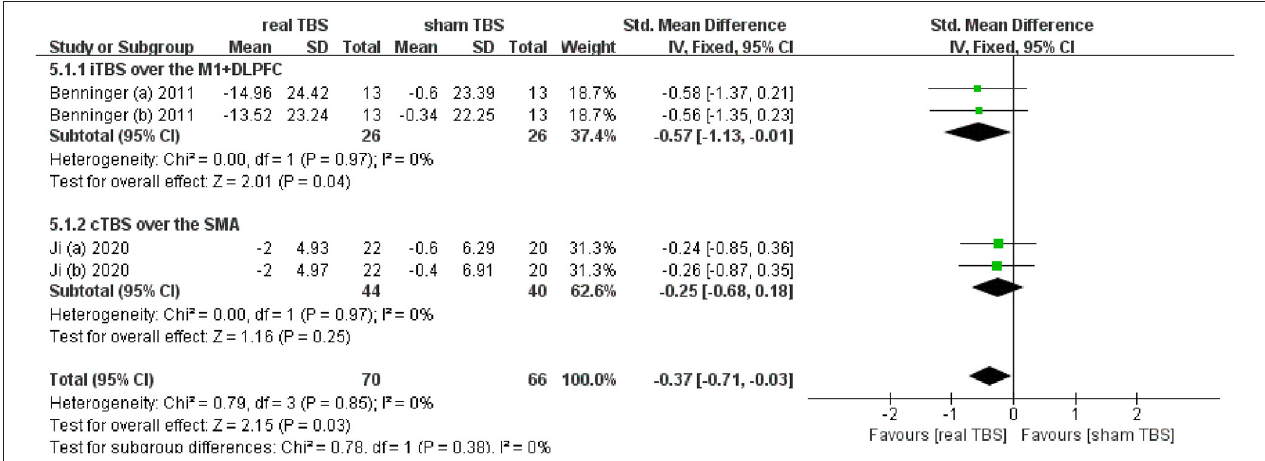
FIGURE 4 | Forest plot and metaanalysis of gait disorder between real TBS and sham TBS in the “off” medicine state: subgroup analysis based on iTBS/cTBS-brain targets.